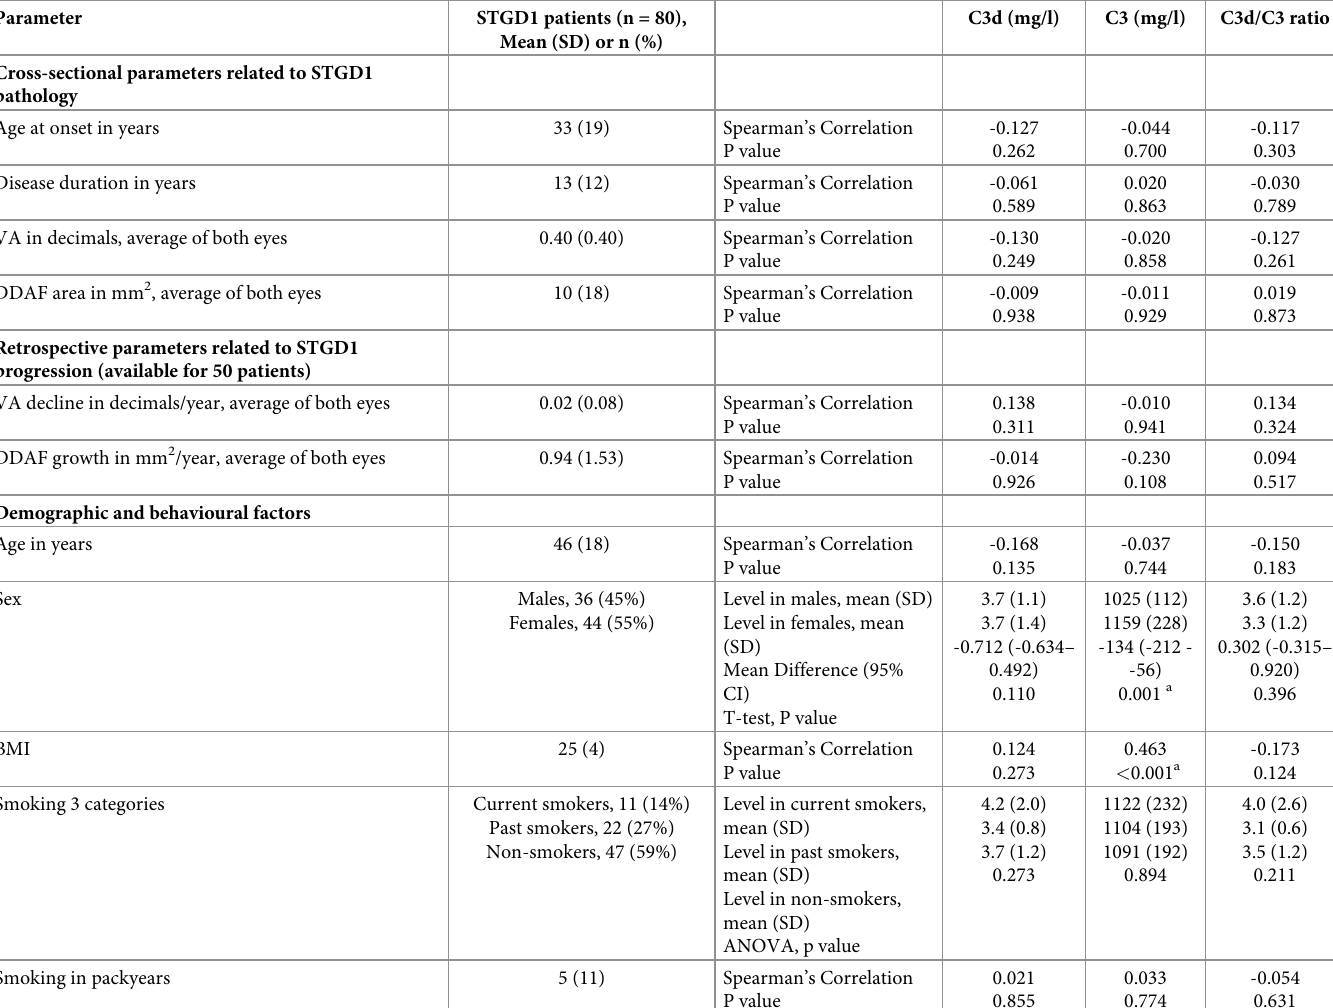
Table 2. Correlation analysis of all parameters within Stargardt disease